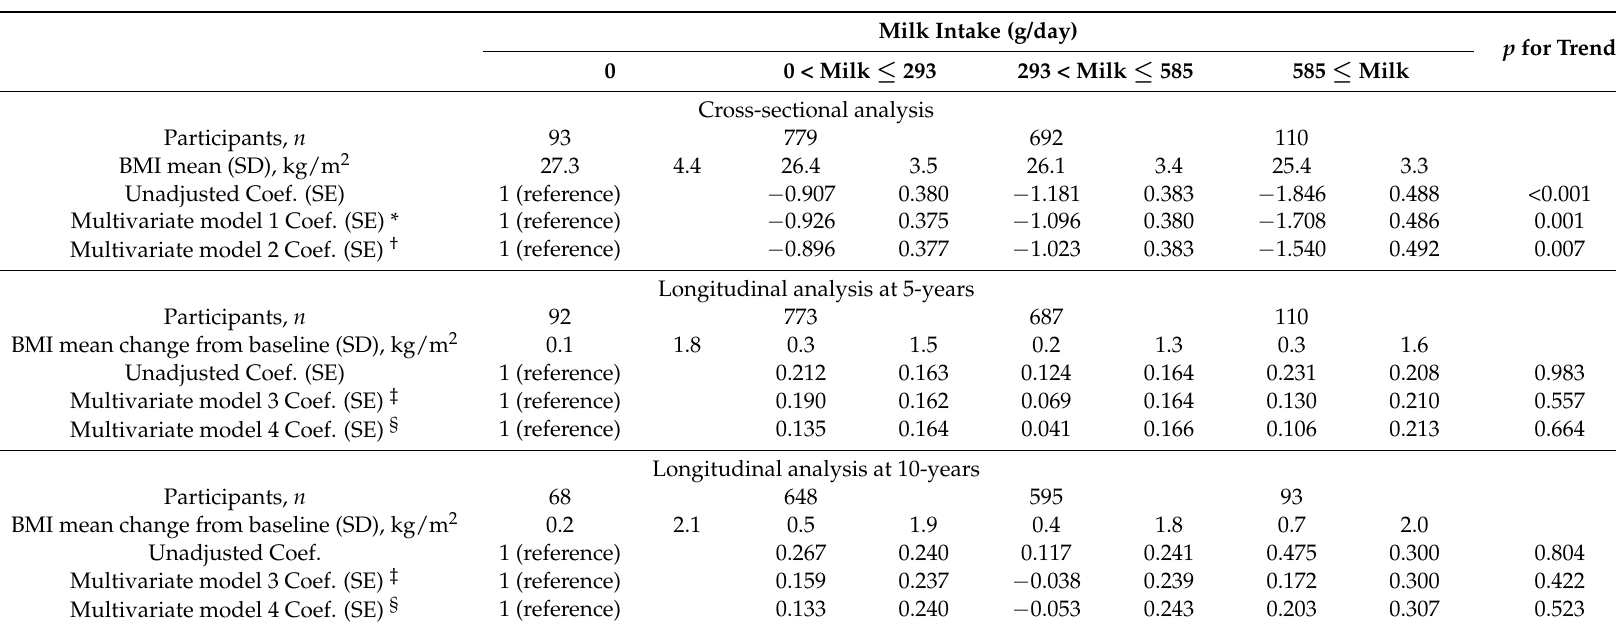
Table 3. Cross-sectional analysis of BMI at baseline and longitudinal analyses over 10-year of BMI changes from baseline by quartile of milk intake. Milk Intake